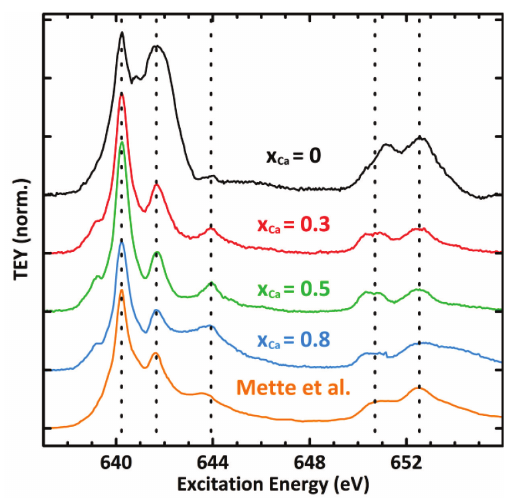
Figure 4. Difference spectra at Mn L-edge between in situ activated and virgin state compared with Mn 2+ spectrum taken from Mette et al.